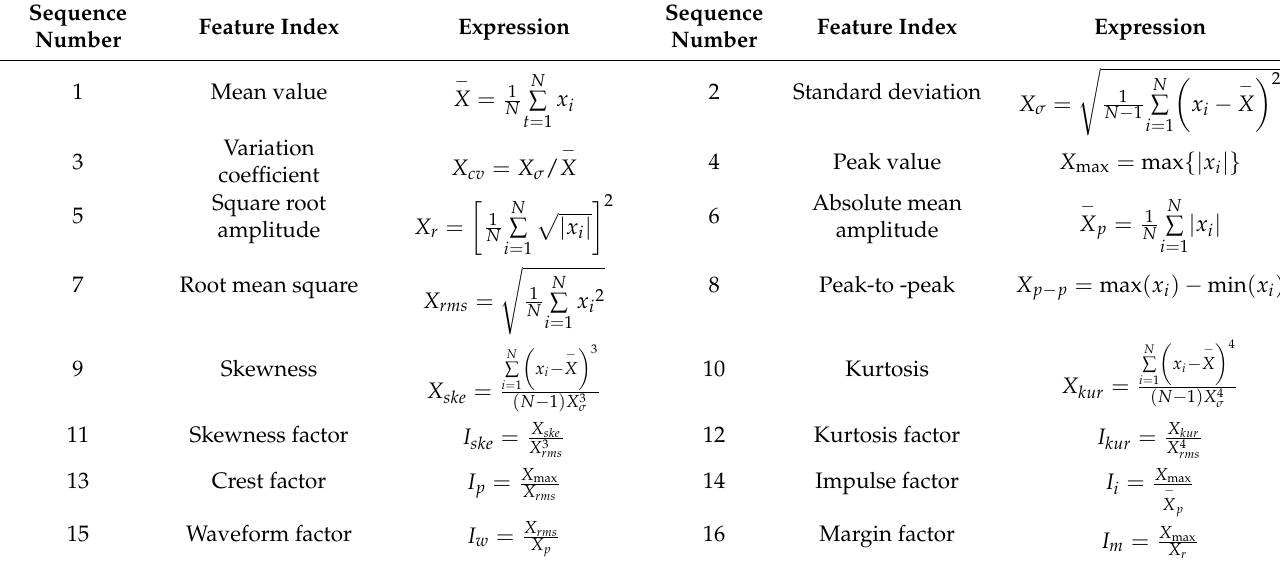
Table 1. Selection of feature